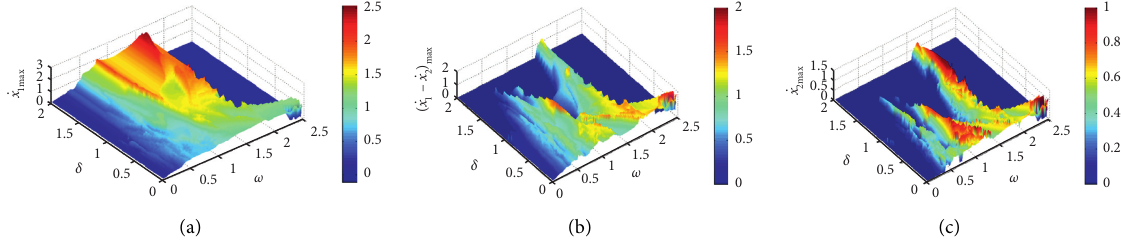
Figure 22: Three-dimensional surface diagrams of the maximum impact velocity of the system associated with each constraint when � δ � 0 . 5. (a) Constraint A δ 1 ; (b) constraint A 12 ; (c) constraint A 2 1 2